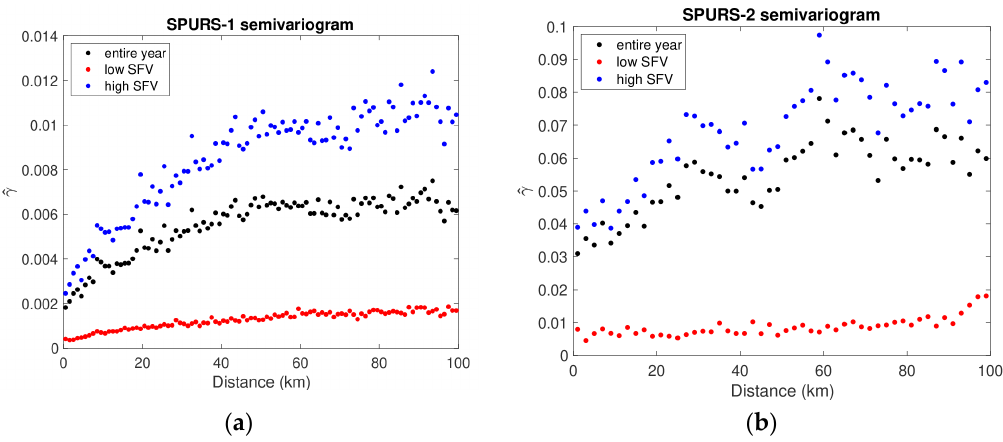
Figure 7. Semivariograms as a function of distance computed from in situ data. ( a ) SPURS-1. Red symbols, January–April. Black symbols, entire year. Blue symbols, May–December. ( b ) SPURS-2. Red symbols, February–May. Black symbols, entire year. Blue symbols, June–January. Note vertical axes are not consistent between the panels.